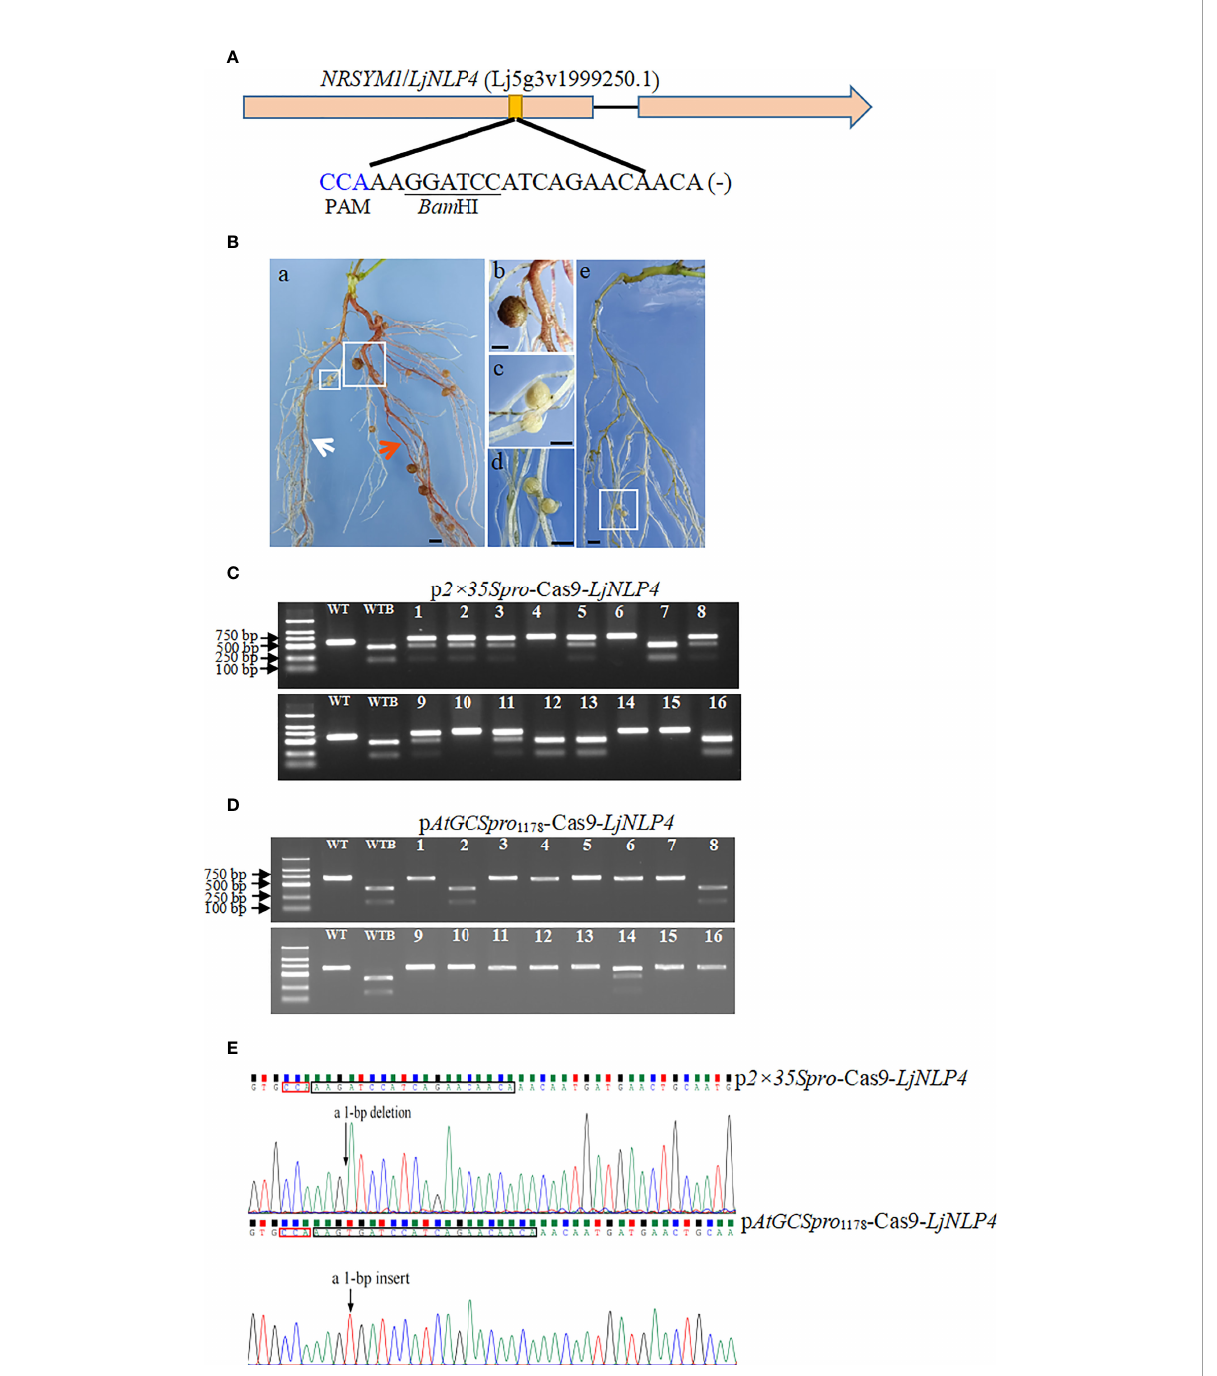
FIGURE 6 PCR-RE assay mutation ef fi ciency in the NRSYM1 / LjNLP4 target loci in L . japonicus . Sequence of an sgRNA designed to target a site within the fi rst exon region of LjNLP4. The PAM sequence is highlighted in blue and the Bam HI restriction site is underlined (A) . L . japonicus hairy roots with edited NRSYM1 / LjNLP4 allele. Transgenic hairy roots with edited LjNLP4Ljnlp4 (white arrow indicated), Ljnlp4Ljnlp4 allele (red arrow indicated) in picture a, and the wild type in picture e; pictures b, c, and d are closed-up of sections a (big white box), a (small white box) and e marked in the boxes, respectively. Bars = 1 mm (B) . PCR-RE assays to detect mutation ef fi ciency in the NRSYM1 / LjNLP4 target loci. Lanes 1 – 16, different independent transgenic hairy roots. Lanes WT and WTB, undigested PCR ampli fi cation fragment and digested wild-type controls by Bam HI, respectively (C, D) . Five lines (#4, #6, #10, #14, and #15) were homozygous or biallelic mutations (C) . 13 lines (#1, #3-7, #9-13, #15, and #16) were homozygous or biallelic mutations (D) . An example shown of mutation in the target site in p 2×35Spro - Cas9 and p AtGCSpro 1178 - Cas9 hairy root, respectively (E)